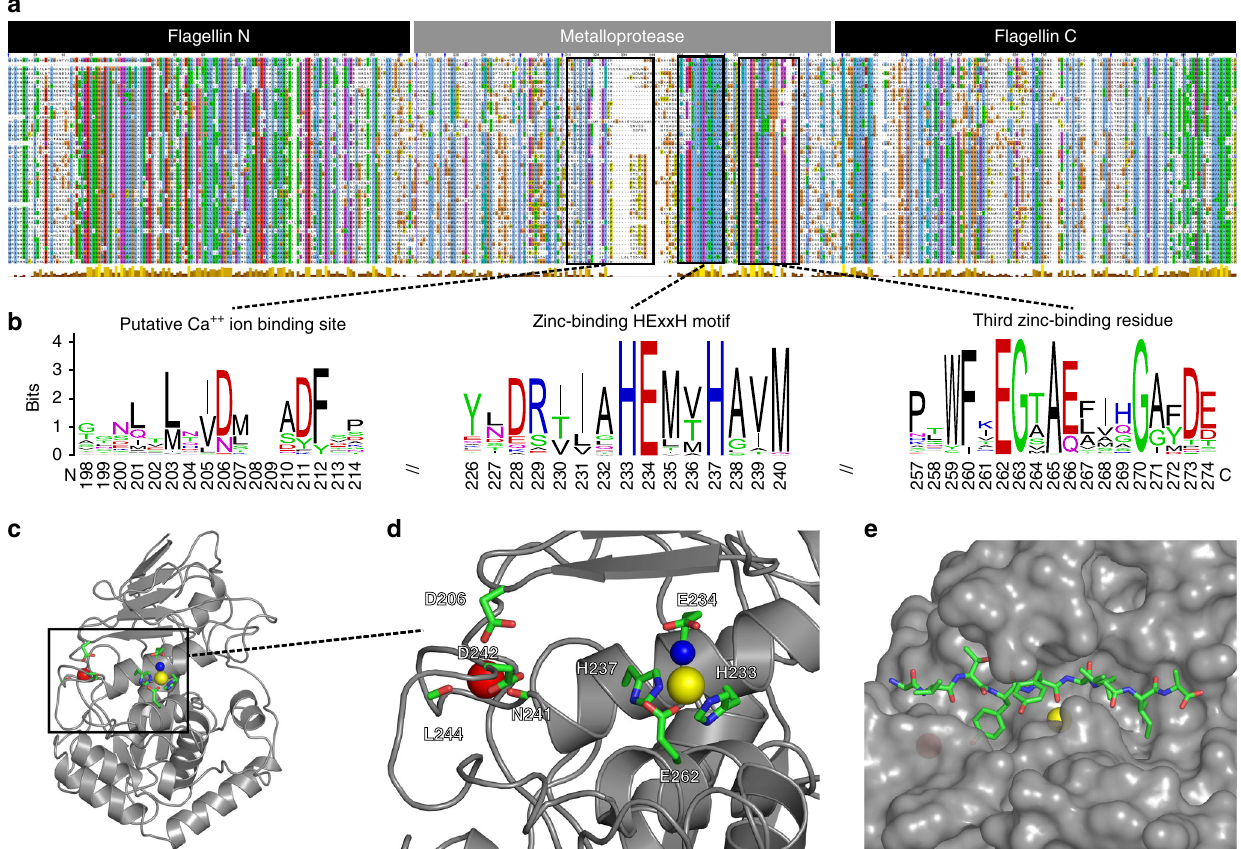
Fig. 3 Sequence analysis and structural modeling of the proteolytic fl agellin family. a Multiple alignment of 86 proteolytic fl agellin sequences from 74 species, with key functional motifs depicted as sequence logos b including a putative Ca ++ ion-binding site ( left ), the zinc-binding HE XX H motif [includes the zinc-binding His233 and His237 and general base Glu234 for hydrolysis] ( middle ) and a motif containing the third zinc-binding residue, Glu262 ( right ). Sequence numbering is according to the FliA(H) sequence, UniProt entry Q8RR94. In addition, the hydrophobic basement-forming residue (Ala265) located below the active site zinc is also conserved. c Structural model of proteolytic fl agella [FliA(H)-hypervariable region] from C. haemolyticum based on the peptidase domain of collagenase H from C. histolyticum (PDB 4ar1). d The zinc-binding HE XX H motif and Ca ++ ion-binding site with important residues labeled. e Peptide-docking model of FliA(H)-hypervariable region complexed with the nonapeptide (AVTYY ↓ LVIA) showing the scissile bond ( ↓ ). The peptide sequence is based on the consensus speci fi city motif derived from the PICS assay